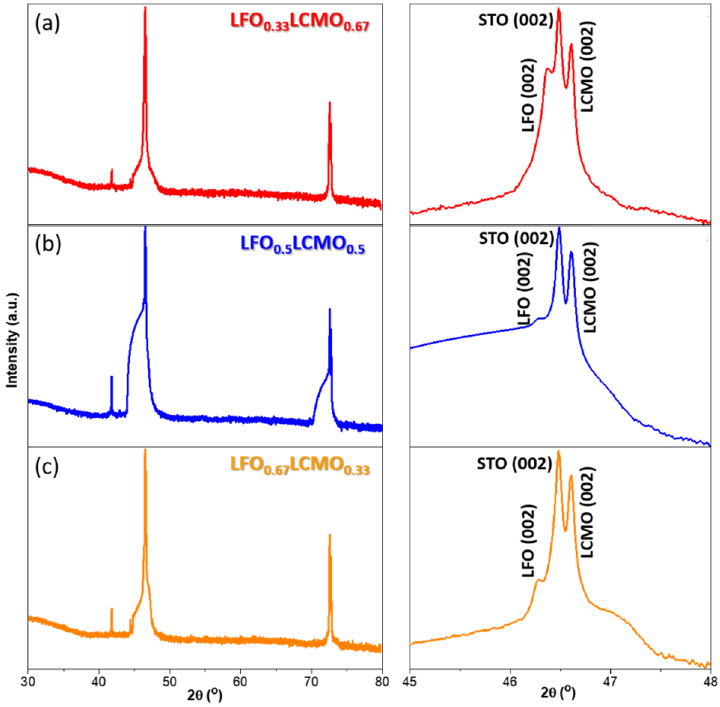
Figure 1. Standard θ –2 θ XRD scans on LFO:LCMO thin films with different compositions. ( a ) LFO 0.33 LCMO 0.67 ; ( b ) LFO 0.5 LCMO 0.5 and ( c ) LFO 0.67 LCMO 0.33 . The right panels are the local scan from 45° to 48°.